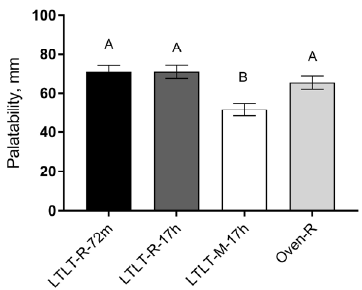
Figure 3. Palatability of the test meals measured on a 100 mm line scale from “Not at all like” to “Like a lot”. (LS means ± SEM, n = 37)). The test meals were prepared according to Table 1. Different letters for each bar indicate a statistical difference ( p < 0.05).